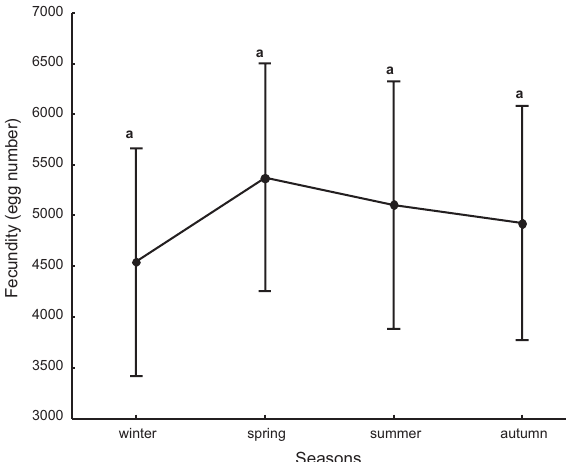
Figure 5. Variation of fecundity along seasons of U. rapax from Itaipu Lagoon. Equal letters shows no statistical difference (p > 0.05).